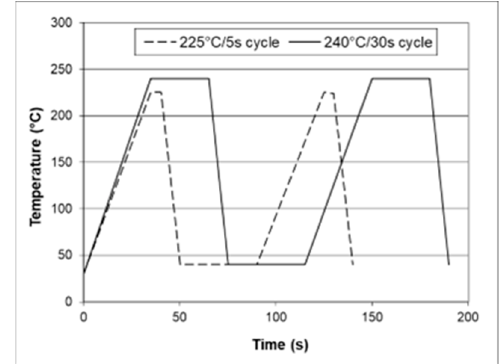
Figure 1. Simulated paint-curing cycles.